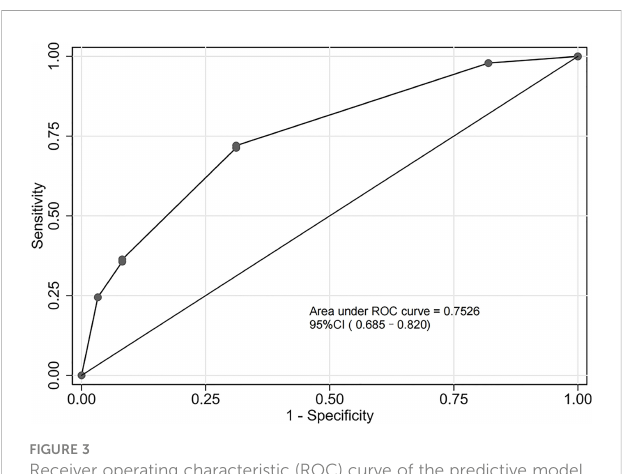
FIGURE 4 Decision curve analysis (DCA) curves of the predictive model in the experimental cohort. The DCA curve showed that the maximum clinical bene fi t could be obtained with the model when the predicted probability was